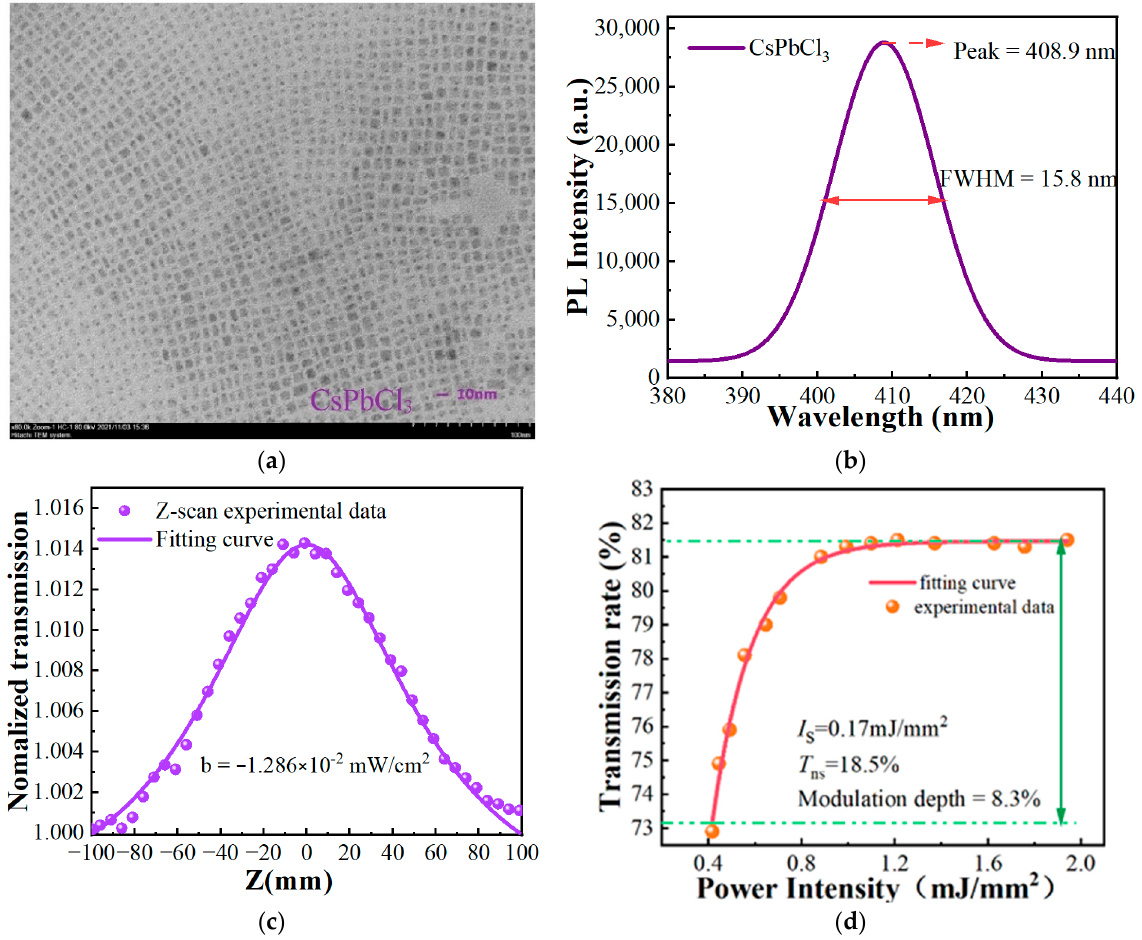
Figure 1. ( a ) TEM image of the CsPbCl 3 perovskite QDs; ( b ) normalized PL spectra for the CsPbCl 3 perovskite QDs’ dispersion; ( c ) normalized open-aperture Z-scan results for CsPbCl 3 QDs at 500 mW incident laser energy with an 80 MHz repetition and an 808 nm femtosecond laser; ( d ) nonlinear transmission of CsPbCl 3 QDs with a modulation depth of 8.3% and 0.17 mJ/mm 2 saturation intensity (the green lines represent the upper and lower limits of the modulation depth).